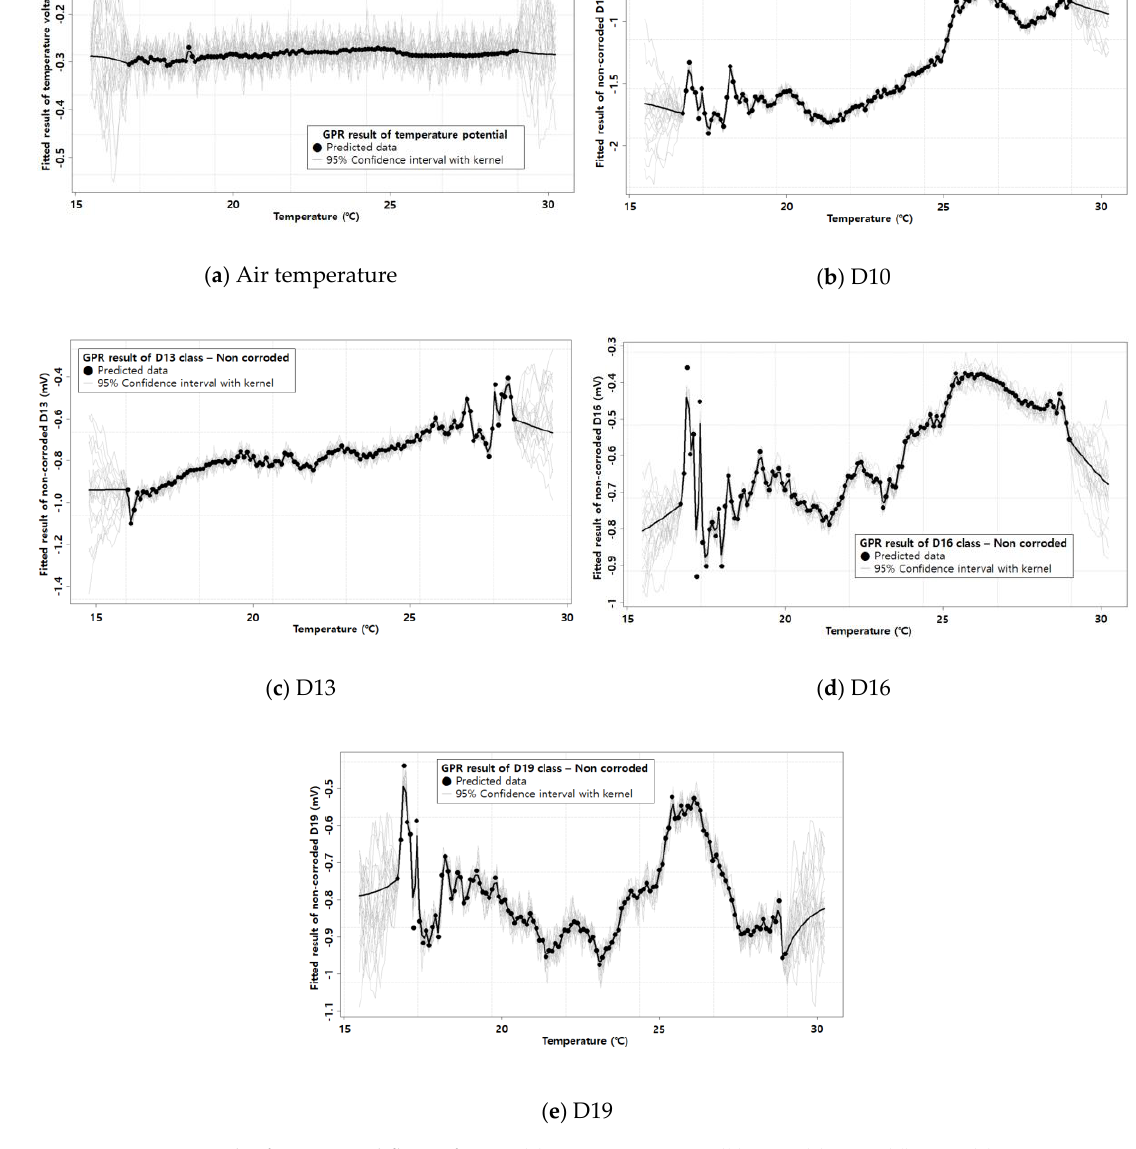
Figure 5. The fitting trend flow of GPR: ( a ) air temperature; ( b ) D10; ( c ) D13; ( d ) D16; ( e ) D19.